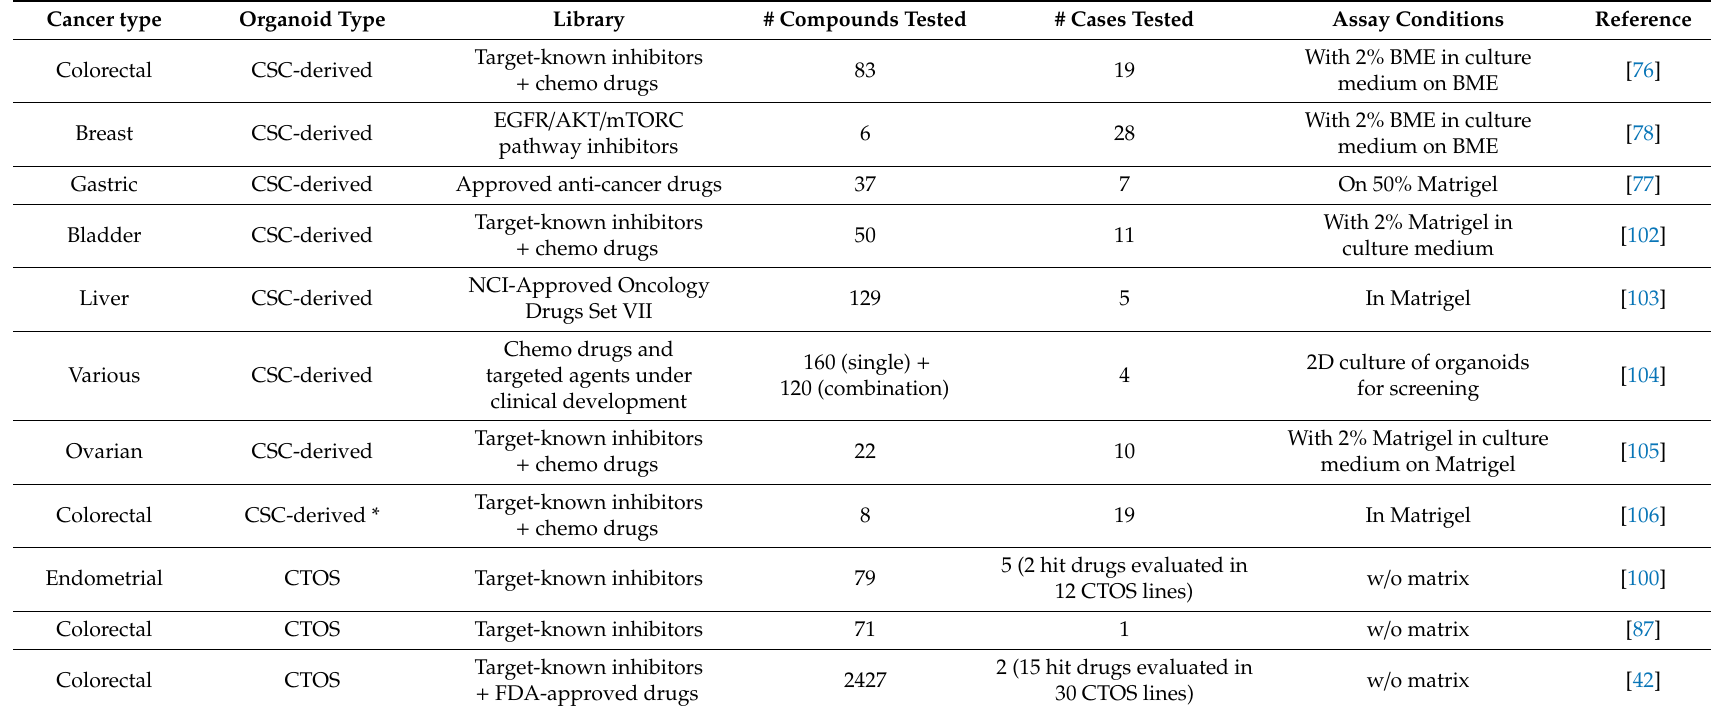
Table 2. Summary of reports of drug screening with organoid